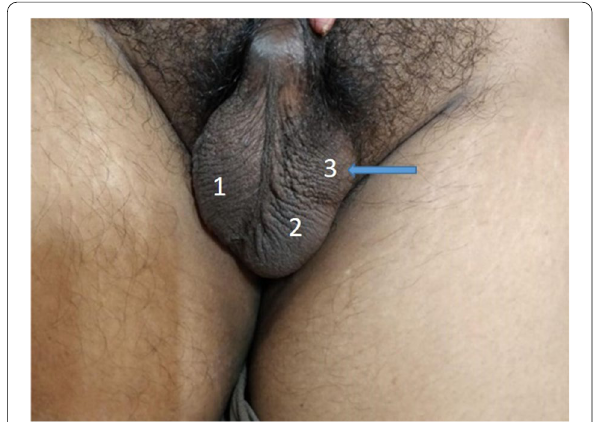
Fig. 1 Clinical presentation of double left testicle